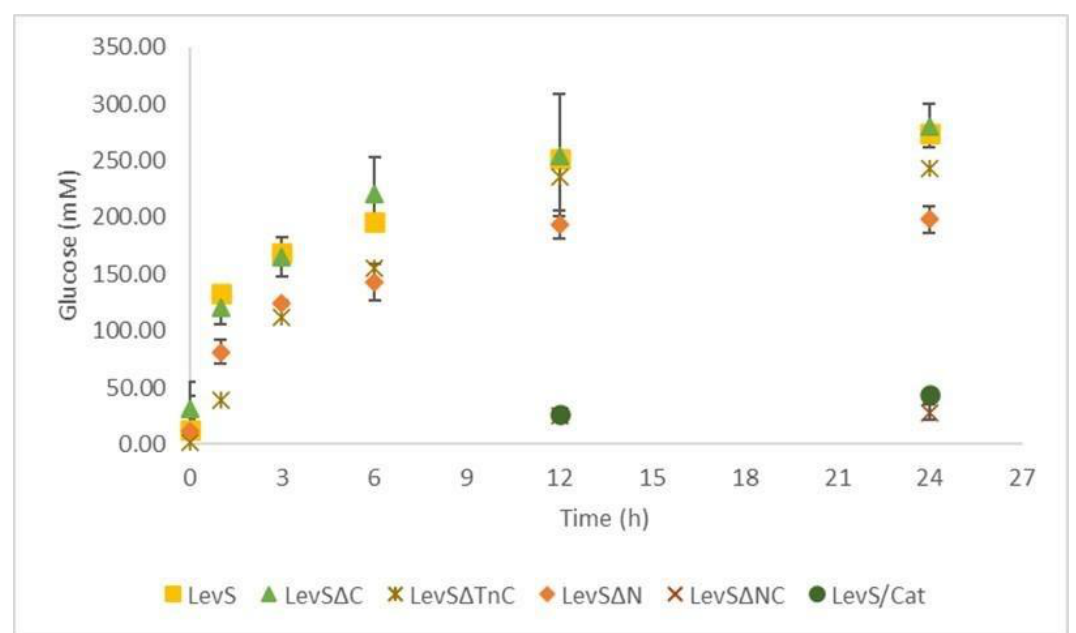
Figure 2. Effect of the additional domains of LevS on the enzymatic reaction. Reaction progress on 100 g/L sucrose and 1 U/mL enzyme for LevS and truncated versions.